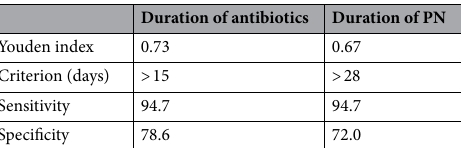
Table 4. Optimal cut-off value for the duration of antibiotics and PN. PN parenteral